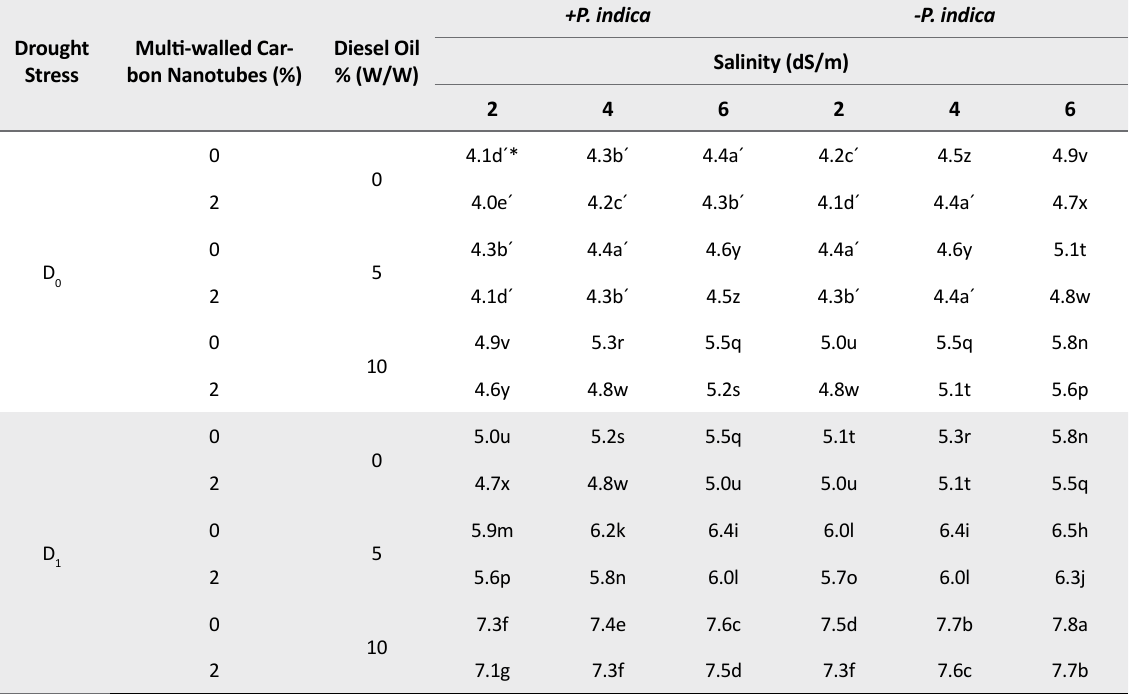
Table 5. The effect of treatments on plant Cd concentration (mg Cd/kg Soil)